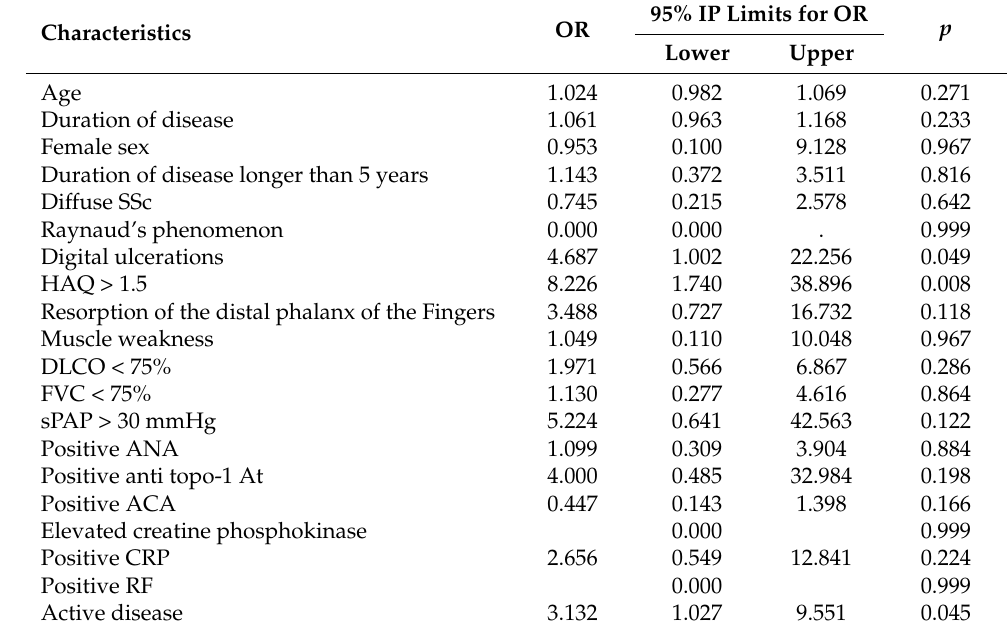
Table 7. Assessment of the association between the examined factors and probability of MRI-detected inflammatory changes in subjects with SSc; results of univariate logistic regression analysis. Characteristics OR